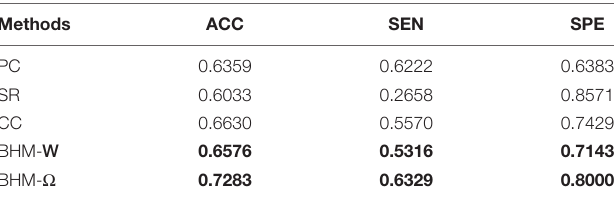
TABLE 3 | The classification results based on five different methods for ASD identification.